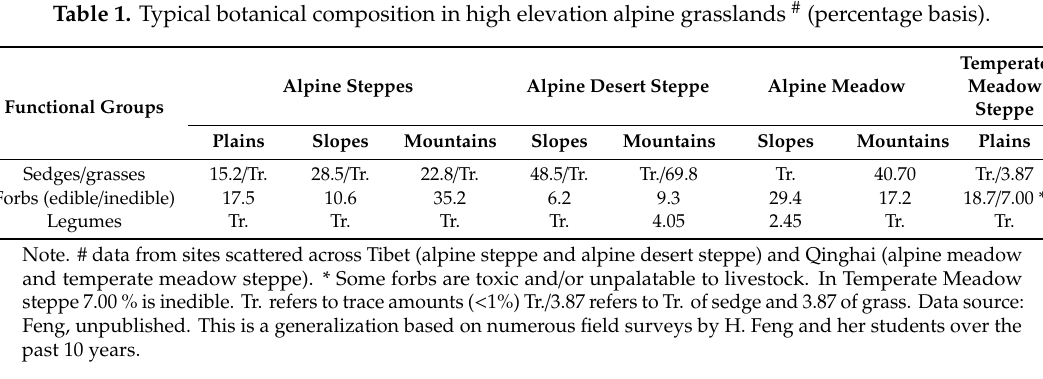
Table 1. Typical botanical composition in high elevation alpine grasslands # (percentage basis).